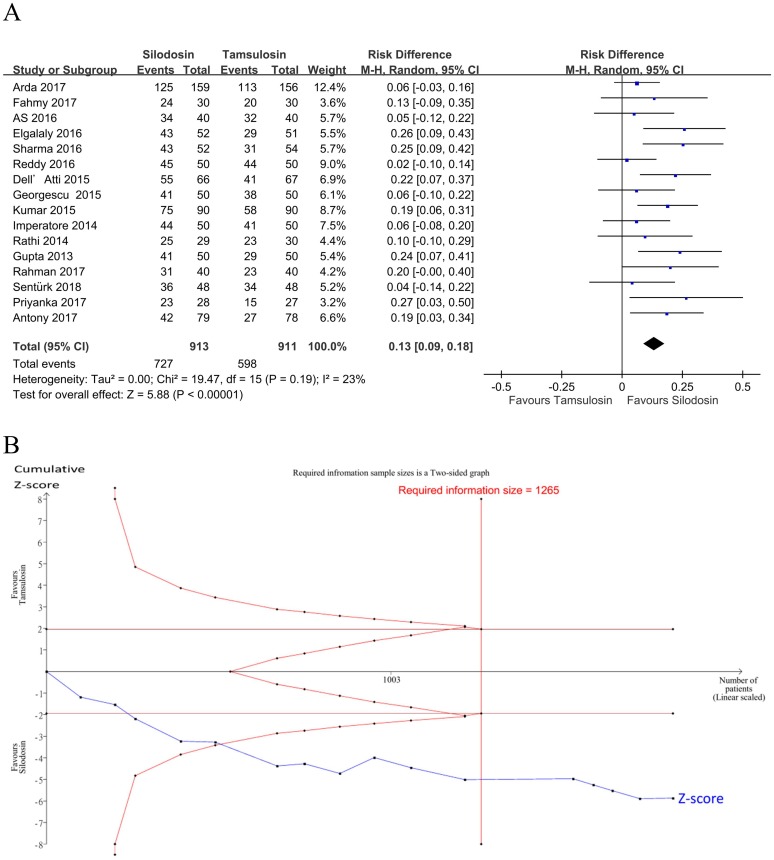
Forest plot and trial sequential analysis for the stone expulsion rate.A: Forest plot. RD, risk difference; CI, confidence interval. B: Trial sequential analysis for the effect of silodosin on the expulsion rate compared to tamsulosin. The risk of a type I error was maintained at 5% with 90% power. The variance was calculated from data obtained from the trials included in this meta-analysis. A clinically meaningful intervention effect for stone expulsion was set to a 15% relative risk reduction based on the assumption of a 65% proportion of the control group. The result showed that solid evidence indicated that silodosin had a higher expulsion rate compared to tamsulosin.